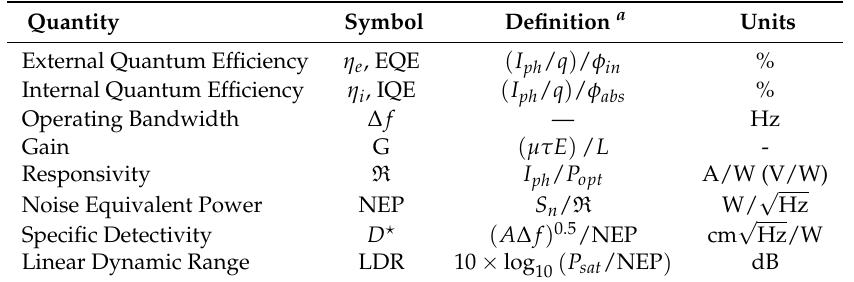
Table 1. Summary of parameters used to characterise photodetectors (PDs). Coupling factors and wavelength dependence of all quantities are omitted for clarity of notation.